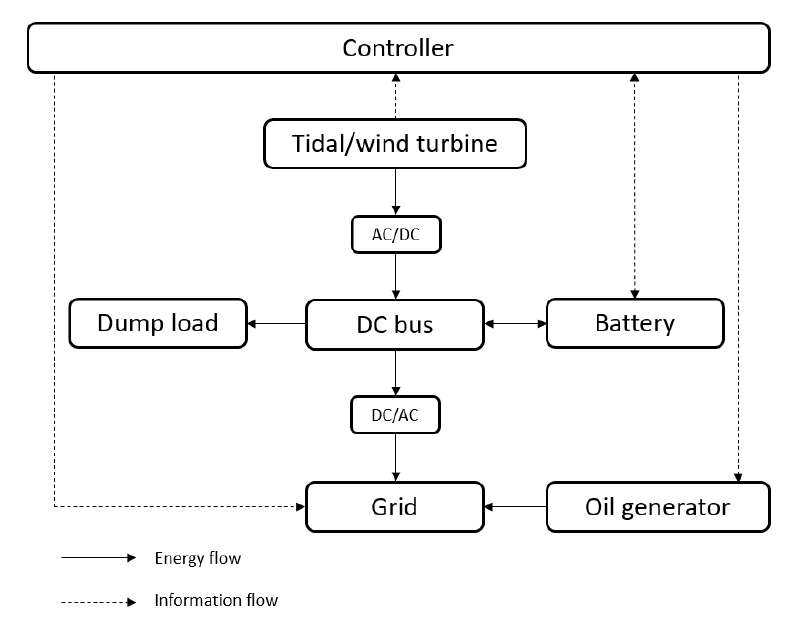
Figure 2. Schematic of the tidal/wind hybrid